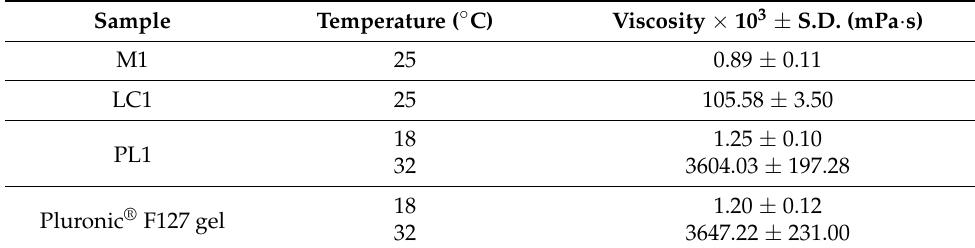
Figure 4. Rheological behavior of the W/O ME (M1) and LC system (LC1) at 25 °C ( A ) and of O/W ME (PL1) at 18 °C ( B ). The viscosity values of the studied systems obtained at 0.08 s − 1 shear rate are reported in Table 4, and the PL1 viscosity as compared to that of 20% Pluronic ® F127 solution at the same temperatures. Table 4. Viscosity of colloidal systems formulated, measured at 0.08 s − 1.